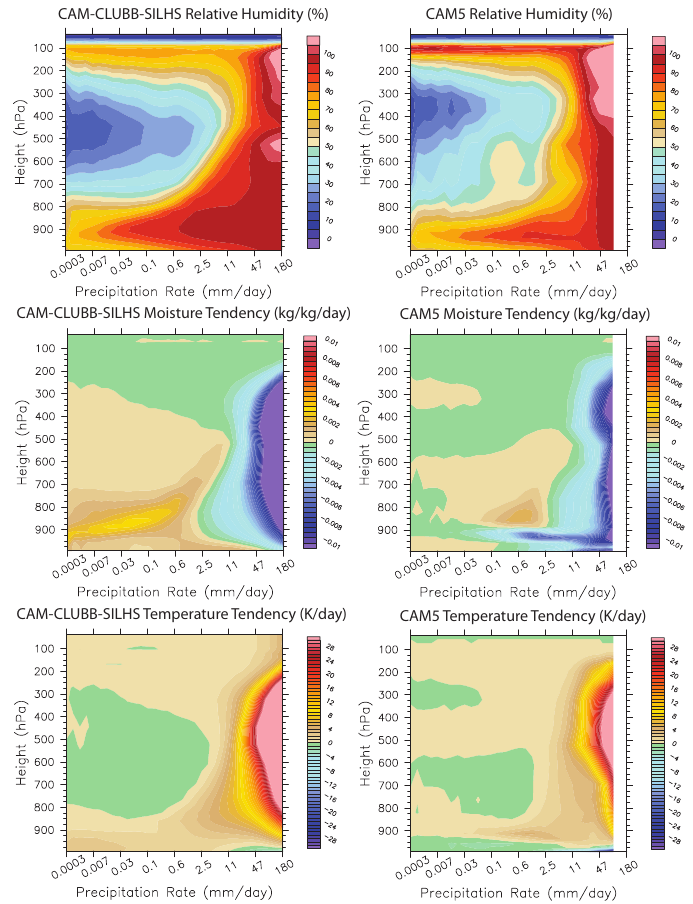
Figure 11. Daily average profiles of fields per daily average value of precipitation for the region between latitudes 15 ◦ N and 15 ◦ S and longitudes 60 to 180 ◦ E over 1 year. Relative humidity for CAM-CLUBB–SILHS (top left) and CAM5 (top right), total physics moisture tendencies for CAM-CLUBB–SILHS (middle left) and CAM5 (middle right), and total physics temperature tendencies for CAM-CLUBB– SILHS (bottom left) and CAM5 (bottom right) are shown. Because CAM-CLUBB–SILHS is a unified parameterization, there is a smoother transition from light to intense precipitation values for all